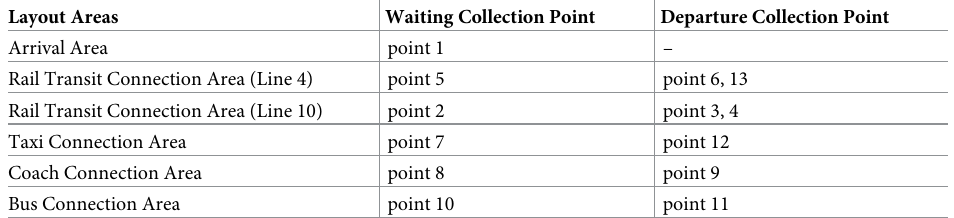
Table 4. Layout of data collection points.